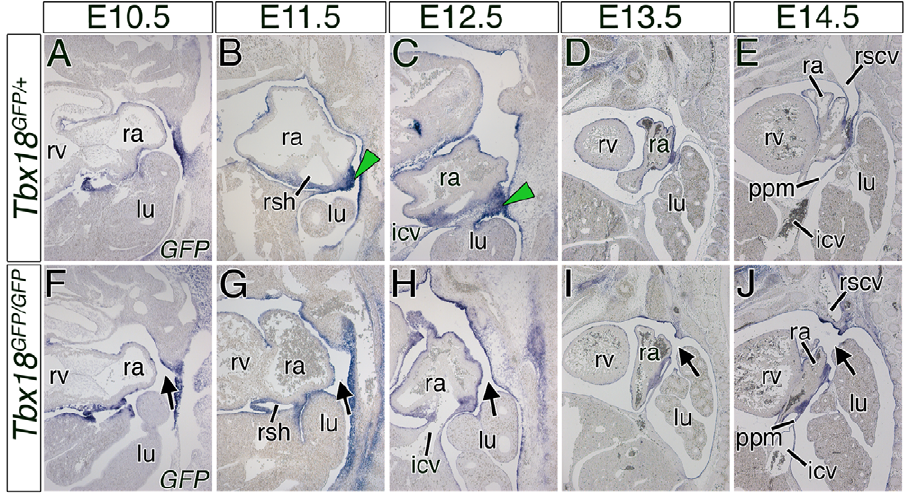
Figure 4. The PPCs in Tbx18 -deficient embryos remain open due to the loss of GFP -positive sinuatrial mesenchymal ridges. (A–J) In situ hybridization analysis of GFP expression on sagittal sections of control and mutant hearts from E10.5 to E14.5. In Tbx18 -deficient embryos the mesenchymal ridges are not established (F–J). Stages are as indicated on top and the genotypes on the left side. Black arrows point to the open right PPC. Green arrowheads mark the GFP -positive mesenchymal ridges in control embryos at E11.5 and E12.5. icv, inferior cardinal vein; lu, lung; ppm, pleuropericardial membrane; ra, right atrium; rscv; right superior caval vein; rsh, right sinus horn; rv, right ventricle.